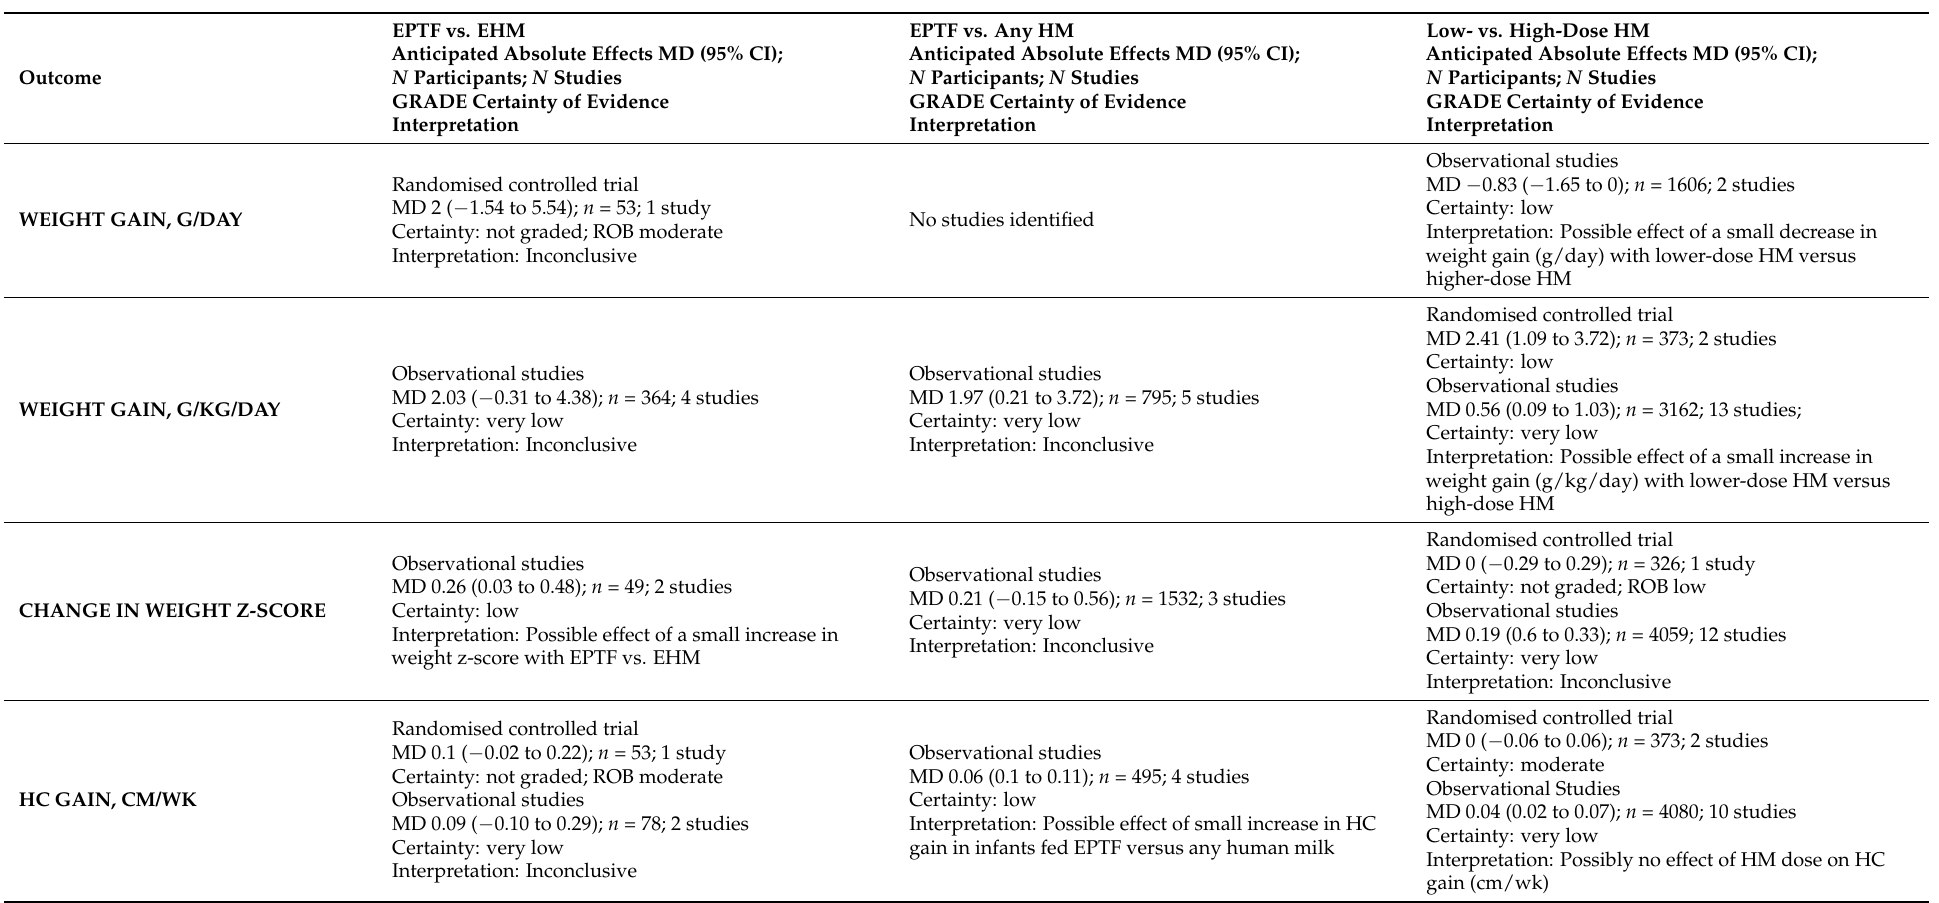
Table 2. Summary of